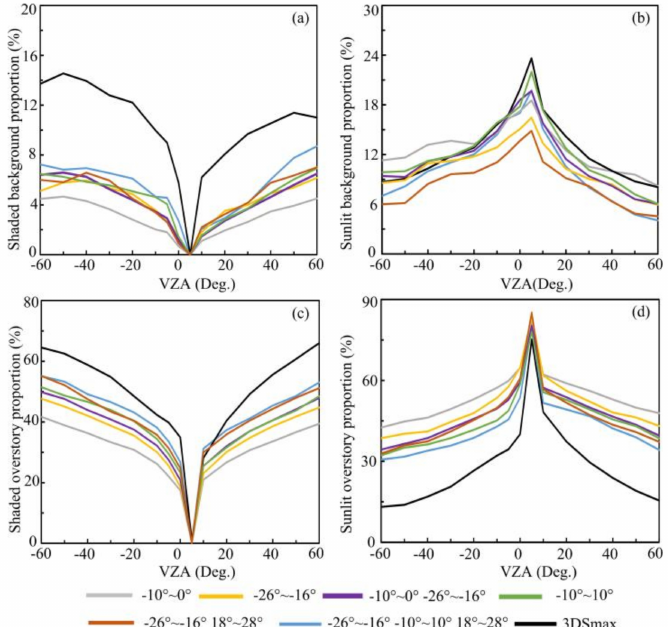
Figure 11. Graphs showing the result of four forest component proportions including shaded forest background (inset a ), sunlit forest background (inset b ), shaded overstory (inset c ) and sunlit overstory (inset d ) with the view zenith angles varying from –60 ◦ to 60 ◦ in solar principal plane under di ff erent scan angles for forest plot WPA-P3. The solid black line represents the 3DSmax-based result and the various colored solid lines represent the ALS-based four forest component results with di ff erent scan angles. The solar zenith and azimuth angles are 5 ◦ and 100 ◦ ,